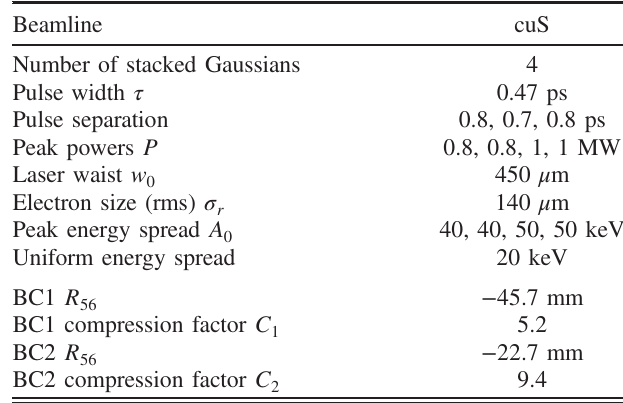
TABLE III. Laser heater shaping parameters to generate a short bunch train at the LCLS-II cuS